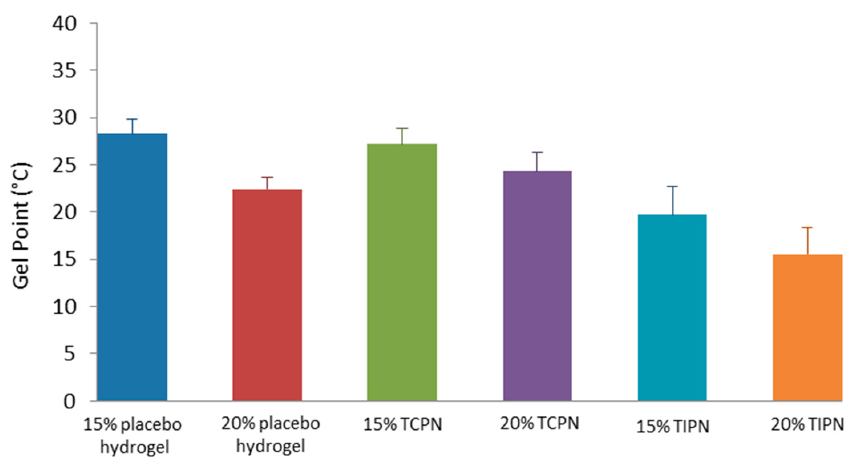
Figure 4. Comparison of gel point temperatures (°C) for different hydrogel formulations.